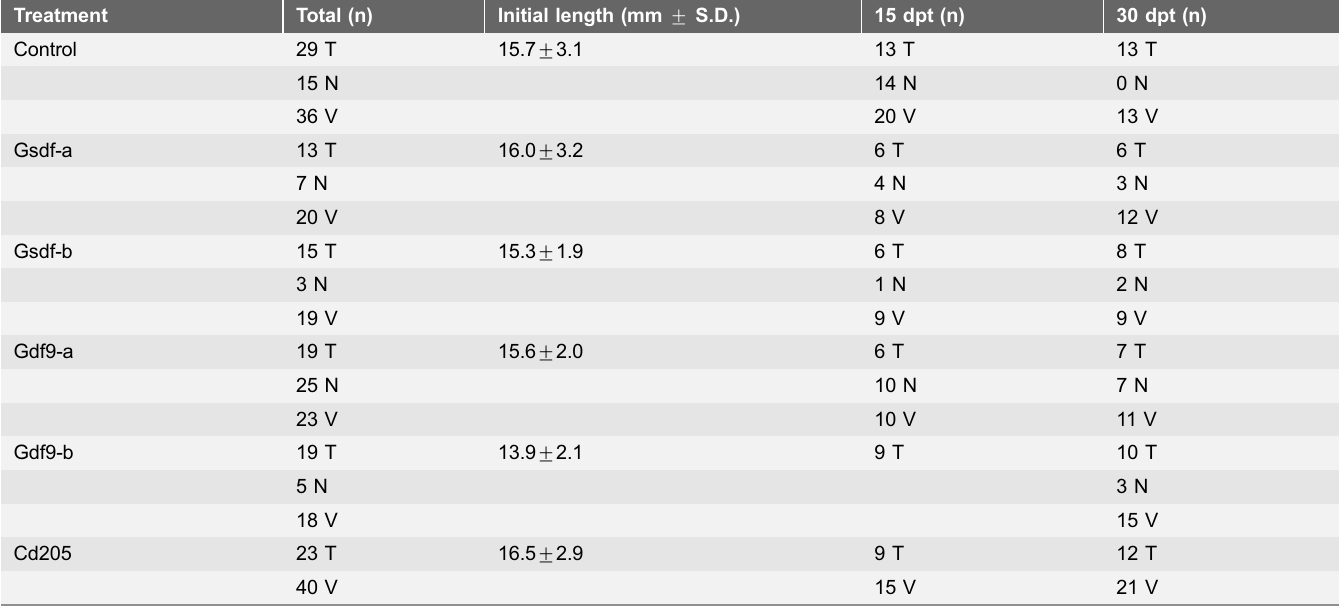
Table 5. Overview of number (n) and lines of fish used in the experiment. Treatment Total (n) Initial length (mm ¡ S.D.) 15 dpt (n) 30 dpt